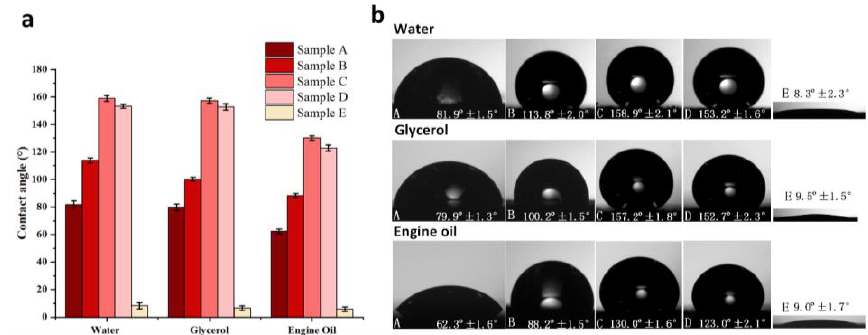
Figure 6. ( a ) Contact angle measurement results of water, glycerol and engine oil for samples A–E; and ( b ) optical shadowgraphs of the static water droplets on these samples during the